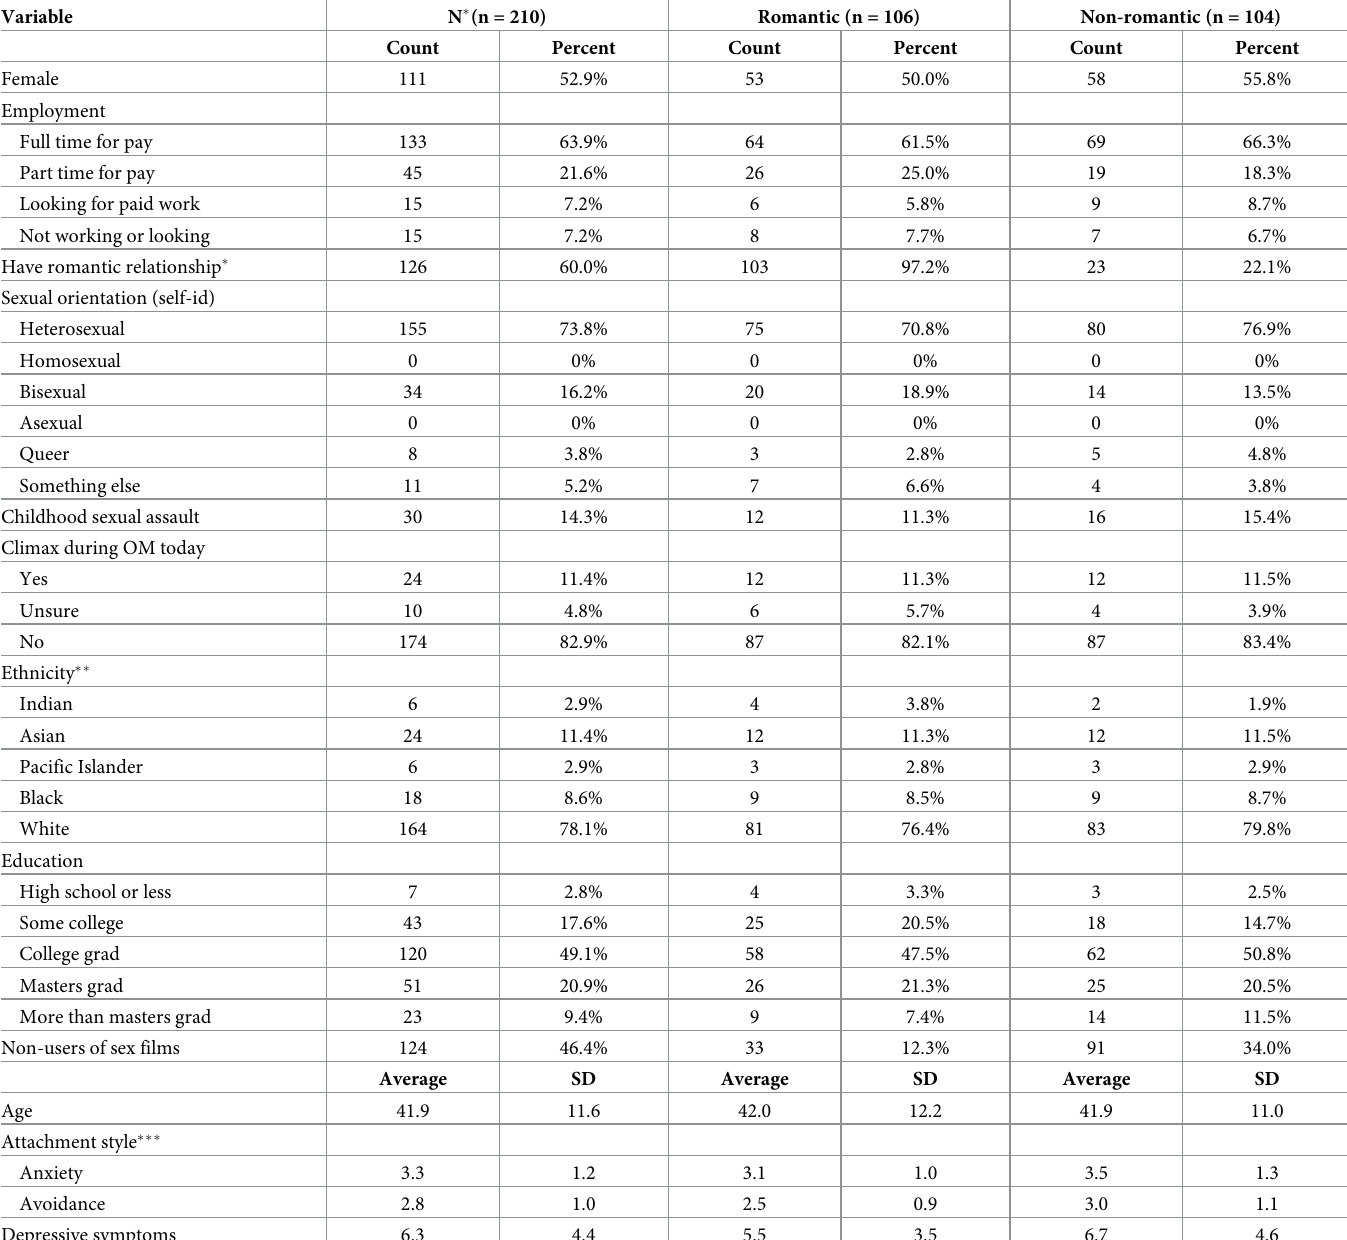
Table 1. Participant information by type of Orgasmic Meditation